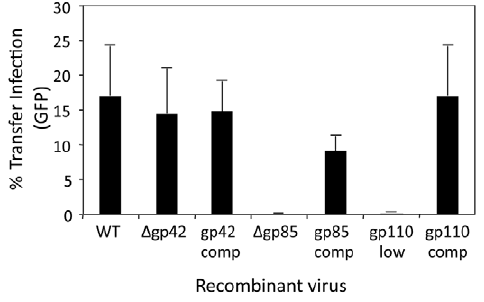
Figure 7. Virus requirements for basolateral surface entry. Transfer infection was performed with B cells infected for 24 h with recombinant EBV carrying deletions ( D ) for the glycoproteins gp42 and gp85, plus the WT virus without reconstituted gp110 (gp110 low), and their respective complemented (restored) glycoprotein counterparts. The B cells were co-cultured with polarized primary tonsillar epithelial cells at the basolateral surface for 1 hour, washed off and the epithelial cells trypsinised from the transwell and re-plated. Epithelial infection was monitored by flow cytometric analysis of GFP expression after 24 hours and plotted as % infection. Due to the inherent variability in infection between donor epithelial cells, assays were performed on triplicates of the same donor